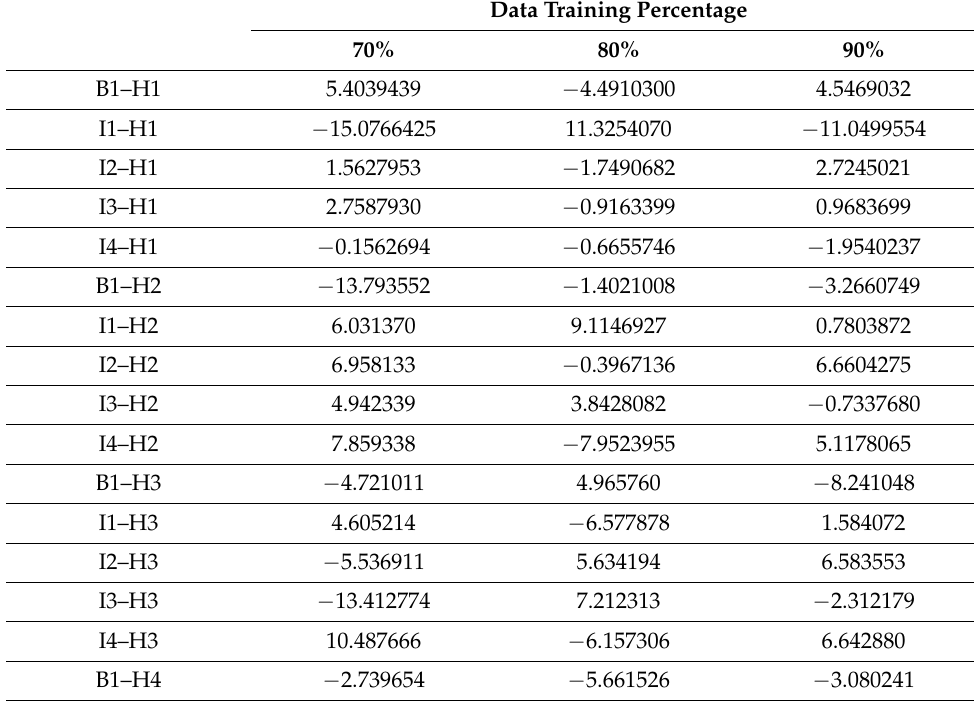
Table 5. The biases and weights of the ANN model developed using logistic activation